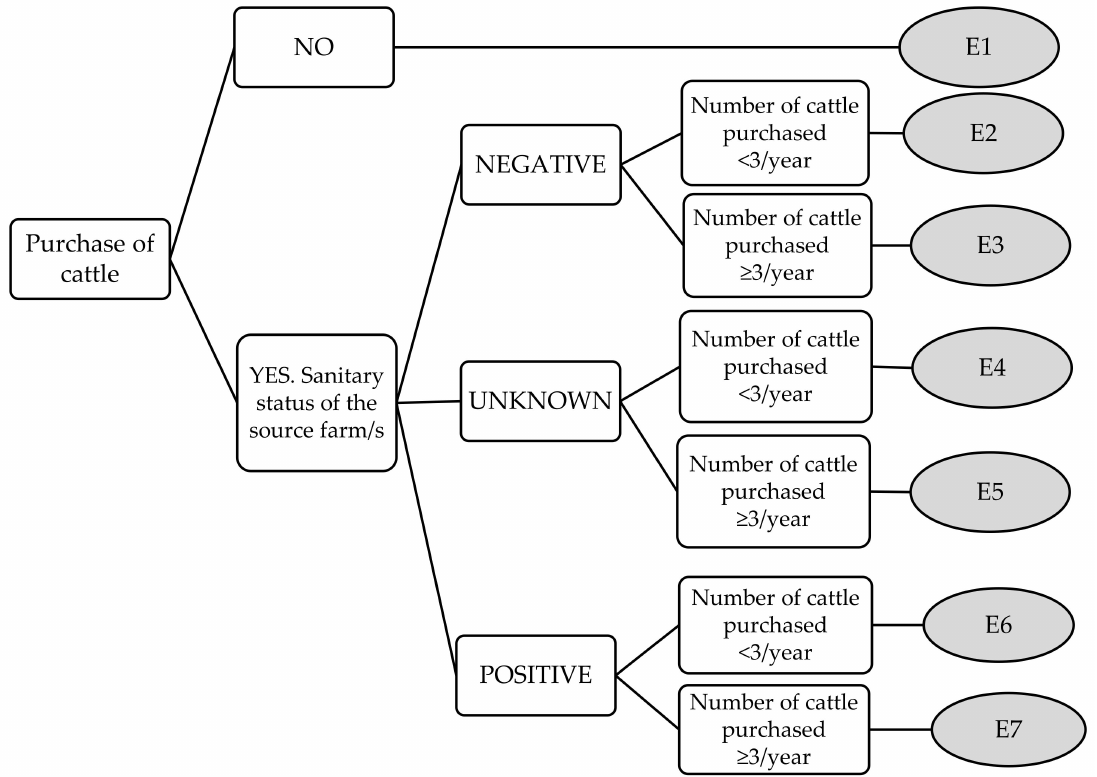
Figure 1. Purchase of cattle decision